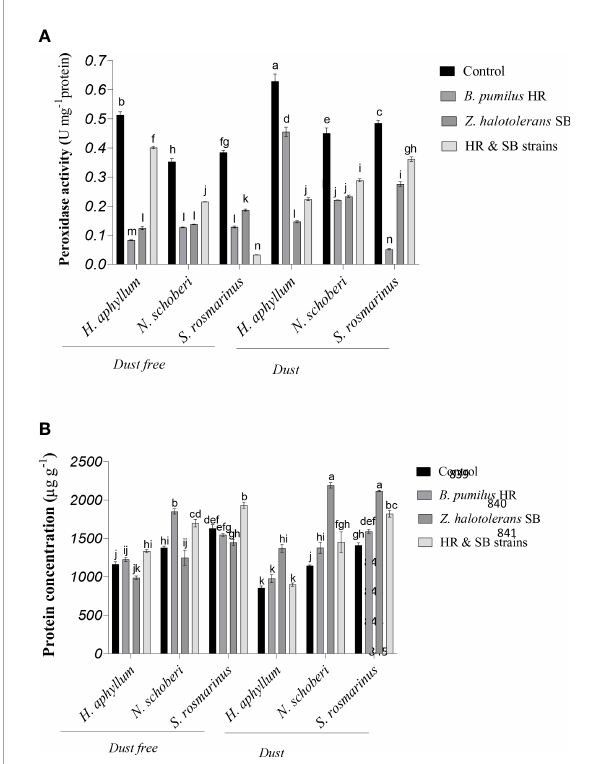
FIGURE 4 Triple interactions of treatments of bacterial strains, three desert plant species of S. rosmarinus , H. aphyllum and N. schoberi and dust on peroxidase activity (A) and protein concentration (B) of the leaves of three plant species grown under greenhouse conditions for fi ve months. Alphabets indicate signi fi cant differences among various treatments (Means ± SE, n = 3) according to Tukey ’ s multiple-range test at p <0.05.